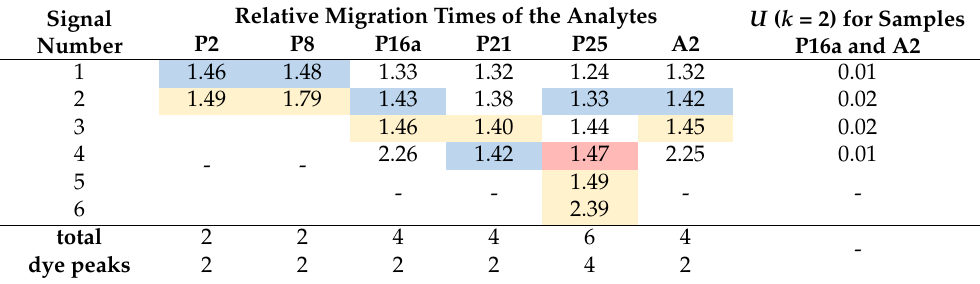
Table 5. Results of differentiation of samples from a group of green fabrics (2) and sample A2; yel- low, red, and blue colors corresponding to signals with the maximum absorption bands at 380 – 490, 490 – 580, and >580 nm, respectively.